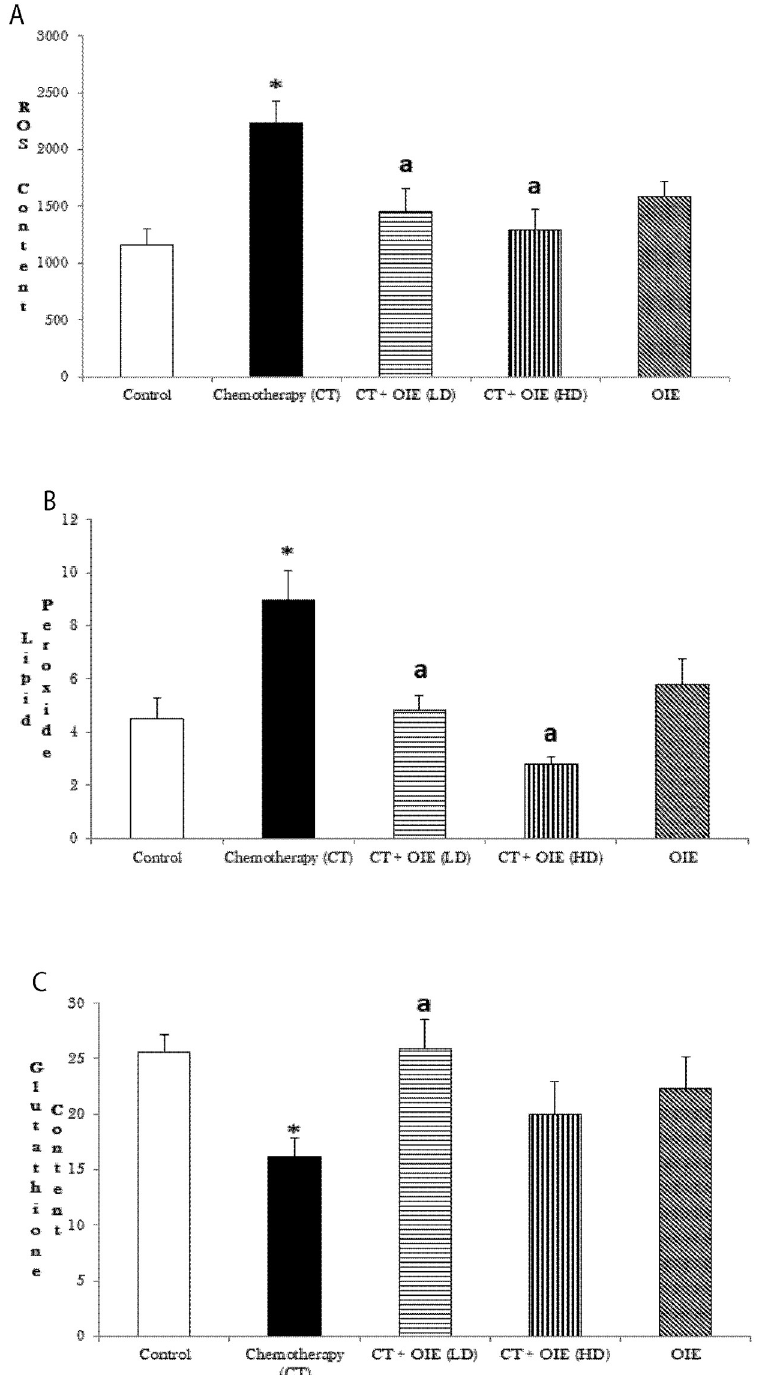
Fig 4. Effect of CT &/or OIE on the levels of ROS, lipid peroxidation and Glutathione content in the rest of brain. (a) The levels of oxidative stress marker-ROS in the cortex were measured spectrofluorimetrically as relative fluorescence units (492/527 nm)/mg protein. (b) Lipid peroxide formation was measured as TBARS formed (532 nm)/ mg protein. (c) Glutathione content was measured spectrofluorimetrically and expressed as GSH content ( μ M)/mg protein, mean ± SEM (n = 5) � p < 0.05 vs. control mice, a p < 0.05 vs. CT mice.